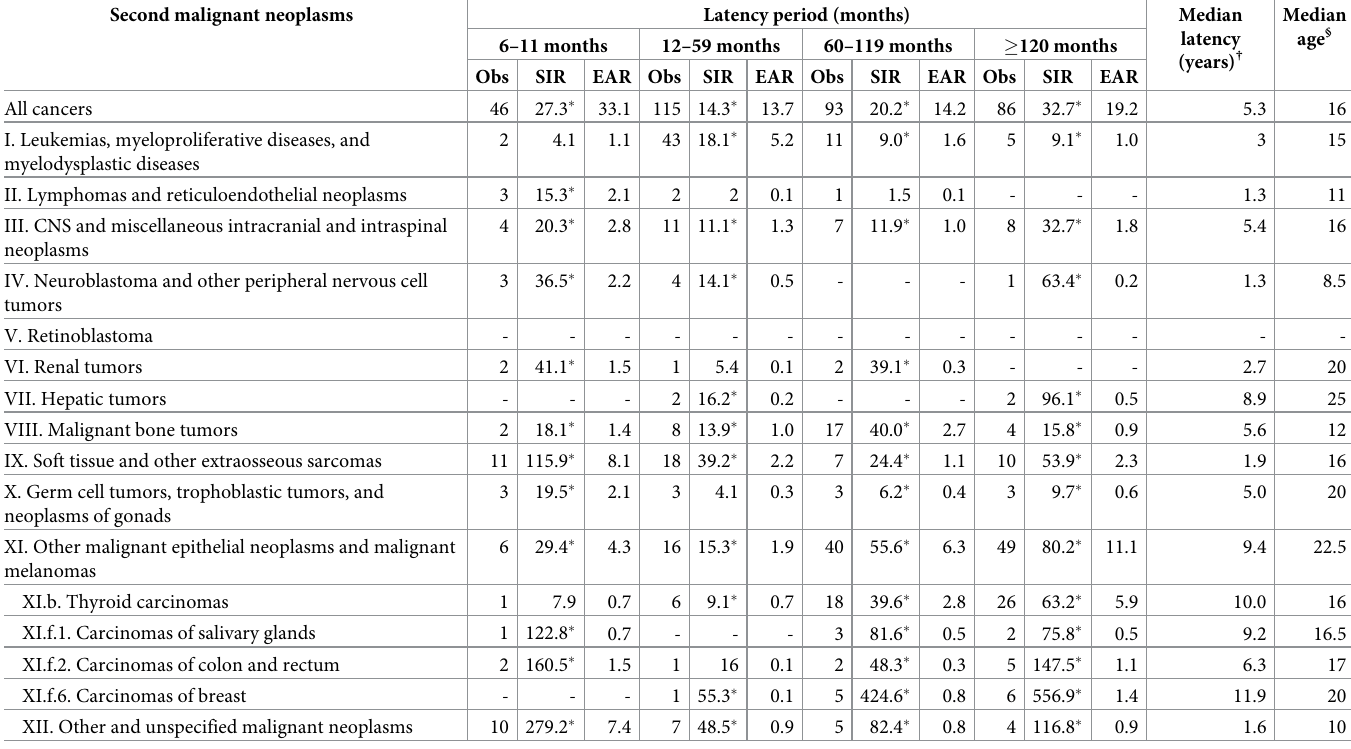
Table 4. Standardized incidence ratios and excess absolute risk of second malignant neoplasms in childhood by latent periods, median latency and median age. Second malignant